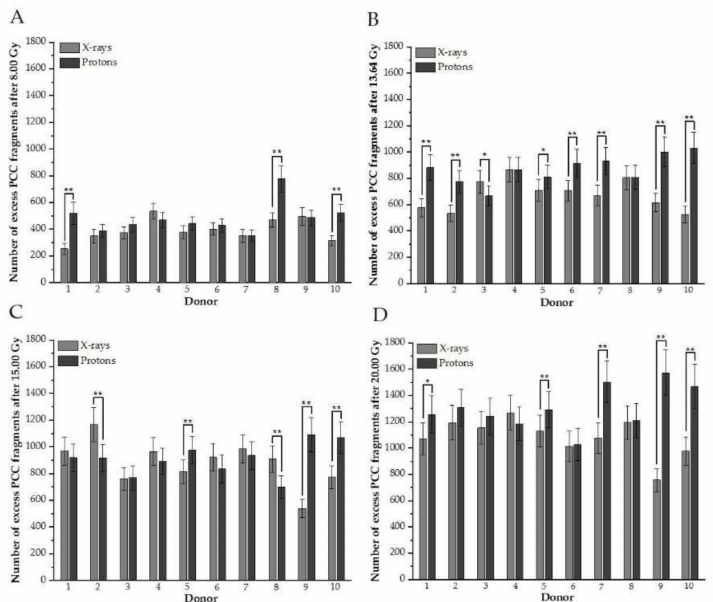
Figure 2. ( A – D ). Distributions of the number of induced excess fragments in G2/M cells irradiated with protons vs. X-rays of 8.00, 13.64, 15.00, and 20.00 Gy, respectively, for each donor. Each column represents scored excess fragments with error bars as a standard deviation. *, p < 0.05; **, p < 0.01. Donor #1, #2, #7, #9, and #10 are female; #3, #4, #5, #6, and #8 are male donors.